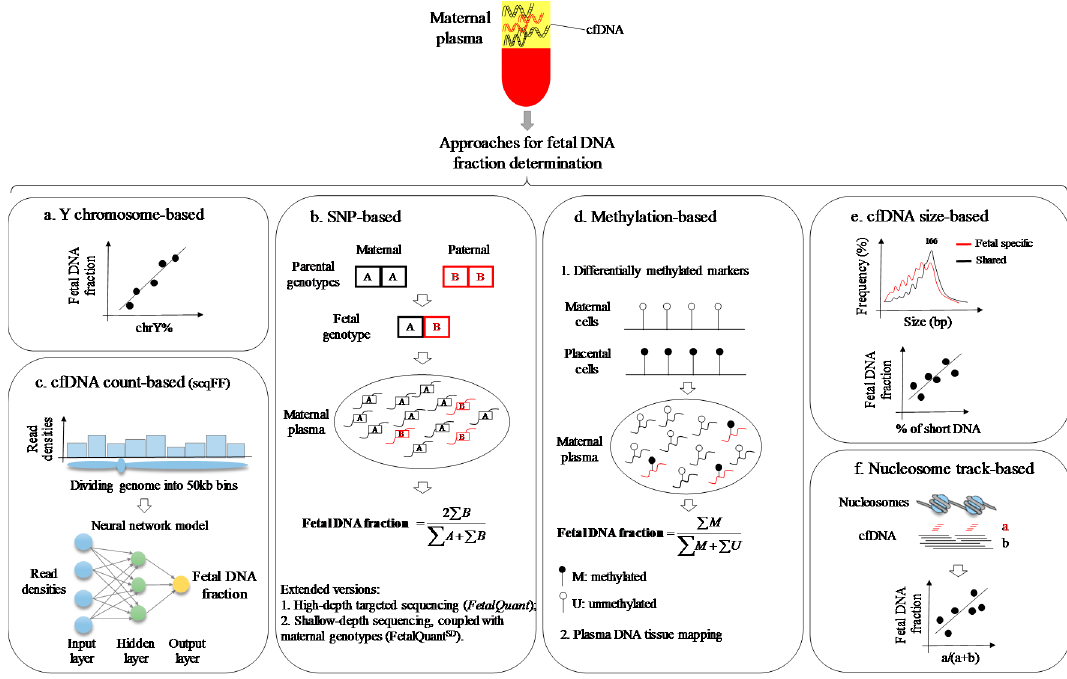
Figure 1. Schematic illustration of current approaches for the determination of fetal DNA fraction in maternal circulating cell-free DNA (cfDNA). ( a ) Y chromosomal (chr) sequence-based fetal DNA fraction estimate [3,22]; ( b ) Single-nucleotide polymorphism (SNP)-based approach. A direct way to estimate the fetal DNA fraction is to use the SNP loci, where both mother and father are homozygous but with different alleles. The resulting fetal genotype is obligately heterozygous. In maternal plasma, the fetal DNA fraction can be directly deduced by calculating the proportion of fetal specific alleles [9,30]. Based on this concept, two extended versions of SNP-based methods for fetal DNA fraction estimate have been developed, namely FetalQuant and FetalQuant SD , which can be used without the need of both paternal and maternal genotype information [31,32]; ( c ) cfDNA count-based approach. Read densities across the genome-wide 50 KB windows are fitted into a neural network model to predict the fetal DNA fraction [33]; ( d ) Differential methylation-based approaches [17,26,34,35]; ( e ) cfDNA size-based approach. The proportion of short cfDNA molecules is correlated with fetal DNA fraction [36]; ( f ) Nucleosome track-based approach. Cell-free DNA distribution at the nucleosomal core and linker regions is correlated with fetal DNA fraction [37].